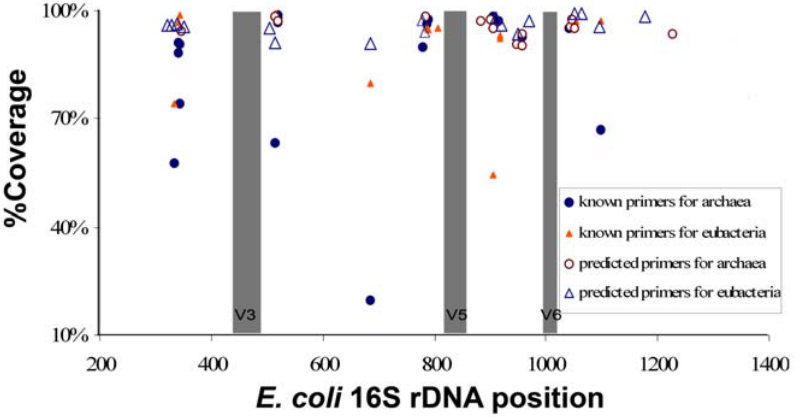
Figure 4. Primer distributions and distances to variant regions. The V3, V5, and V6 regions are variant regions of the 16S rRNA genes. Their locations on the E. coli 16S rRNA gene were shown as shadowed regions. The relative distances of the primers (including the known and predicted primers) to the three regions were shown.